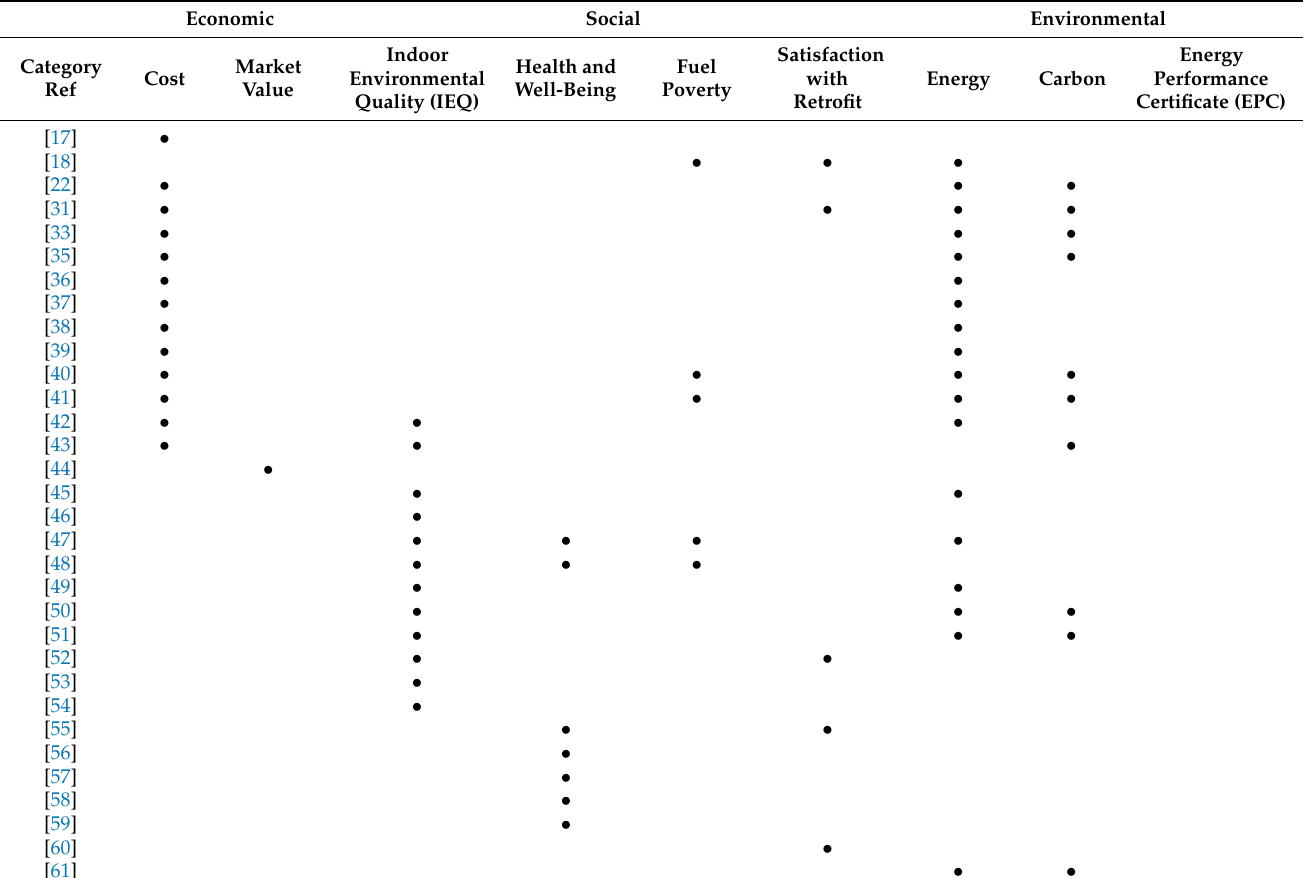
Table 1. KPI categories identified in the existing literature for demonstrating the multiple benefits of retrofitting to householders.